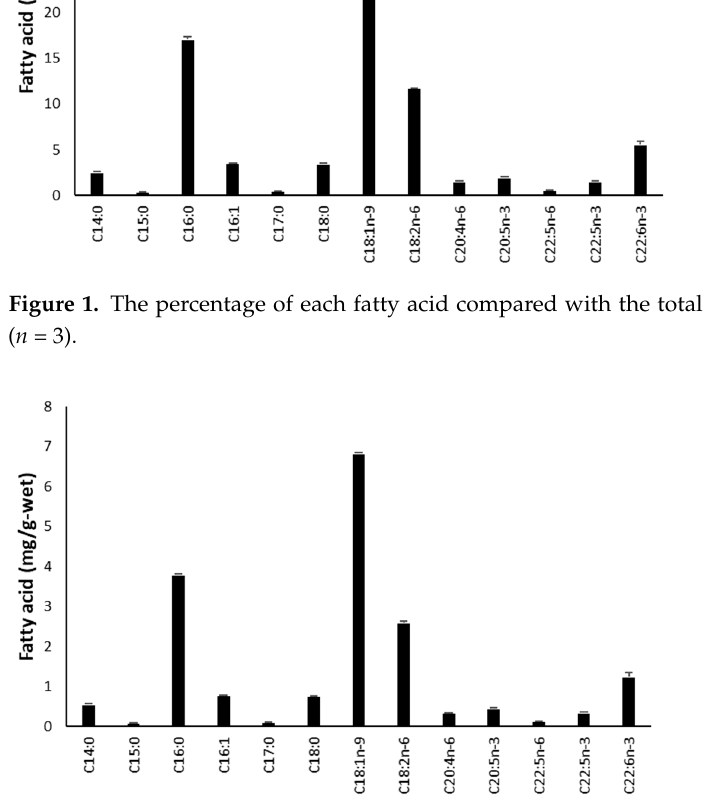
Figure 2. Fatty acid composition (mg/g wet weight) of internal organs of white sturgeon. Values are mean ( n = 3).